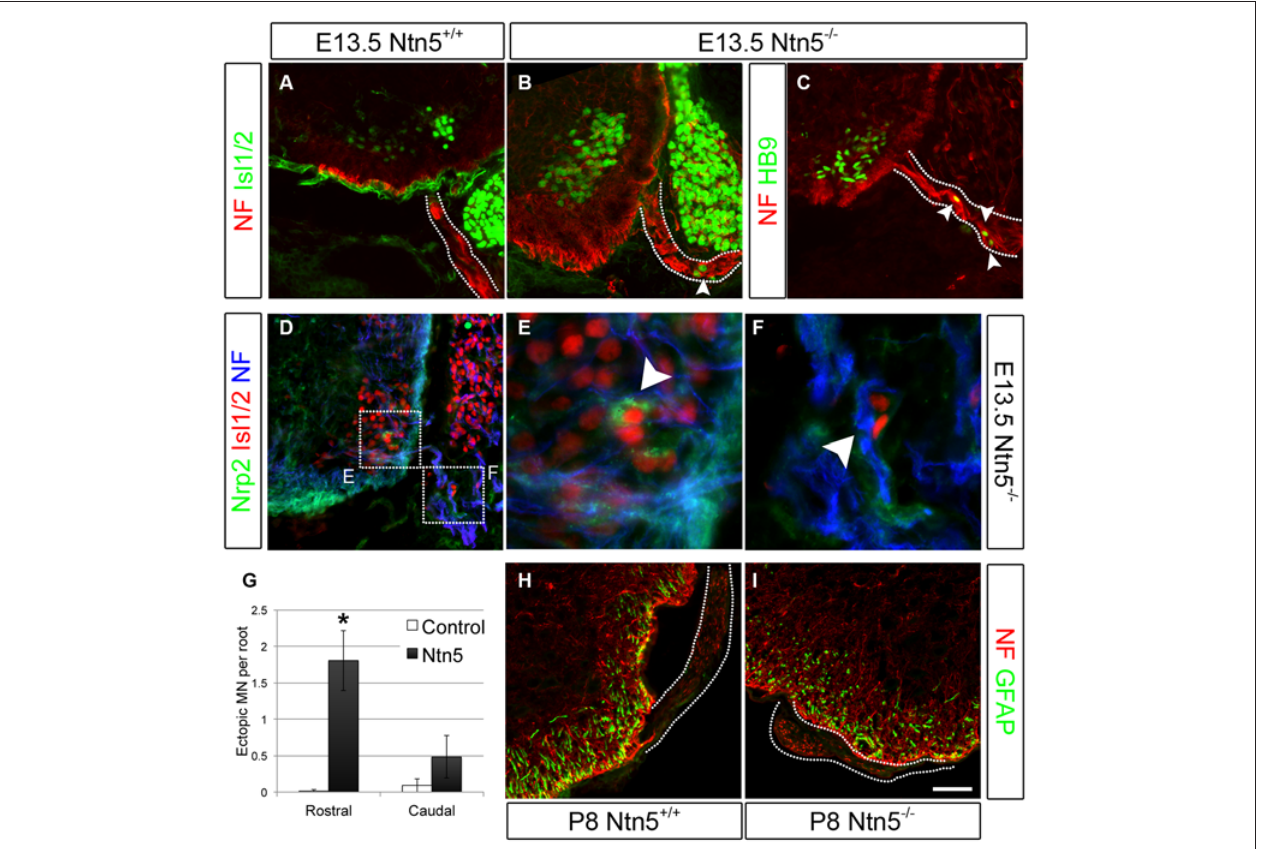
FIGURE 3 | Netrin5 keeps MNs cell bodies from migrating out of the CNS . Immunolabeling of E13.5 embryos showed ectopic MN cell bodies in the ventral roots of Ntn5 − / − mutants. Ectopias were not observed in controls (A) , but cells positive for Islet 1/2 (B) and HB9 (C) were observed in mutants, indicative of MNs. While some MNs were positive for nrp2, (D,E) ectopic MNs in mutant embyros were not (D,F) , suggesting that these MNs are a different population from those known to use a semaphorin6A/nrp2 mechanism. Furthermore, there were more ectopias in the rostral half of the embryo than in the caudal (quantified in G ) which is the inverse of what was observed in Nrp2 mutant embryos. CNS glia such as GFAP-positive astrocytes did not enter the ventral root (H,I) indicating this aspect of the CNS/PNS boundary was not lost. NF, neurofilament. Scale bar is 50 µ m. ∗ indicates P < 0.05 by student’s t